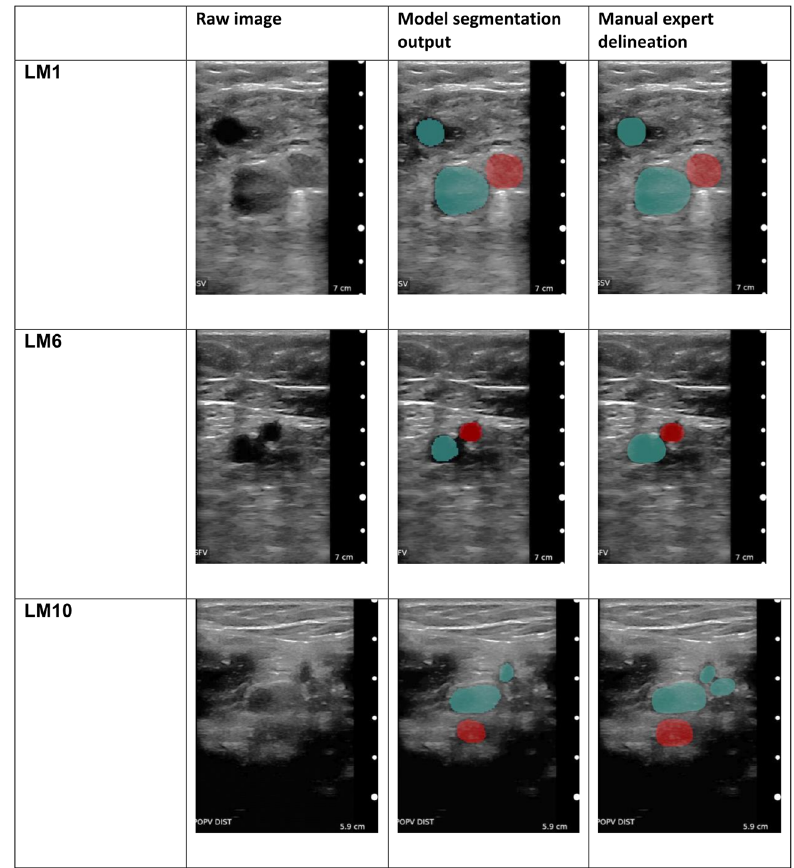
Fig. 2 Qualitative example images for our model ’ s segmentation performance. The segmentation is robust throughout compressions. The vein area is evaluated for complete compressibility to exclude DVT. Device: Clarius L7